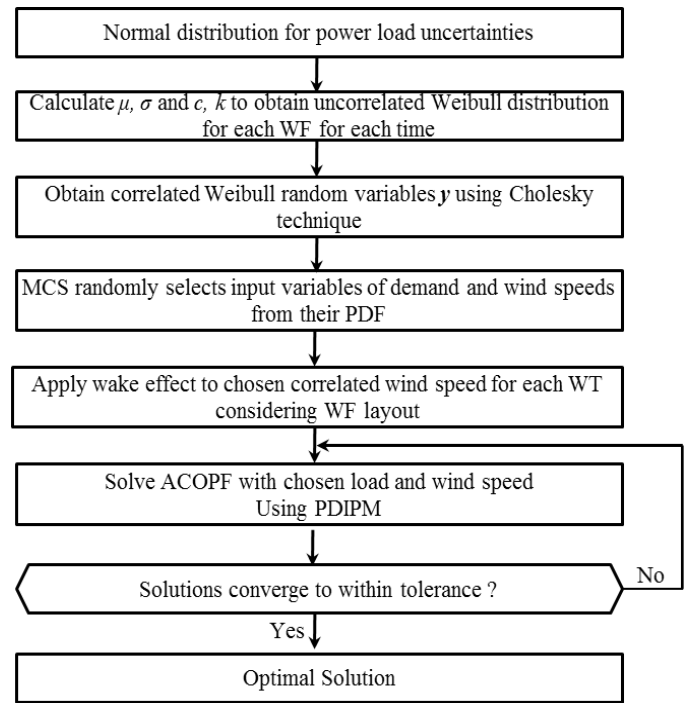
Figure 5. Solution procedure